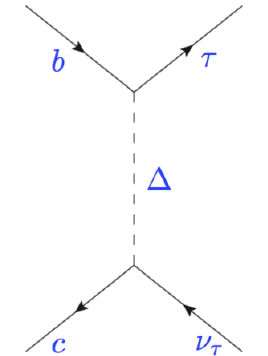
Figure 1 . Contribution to b stands for the